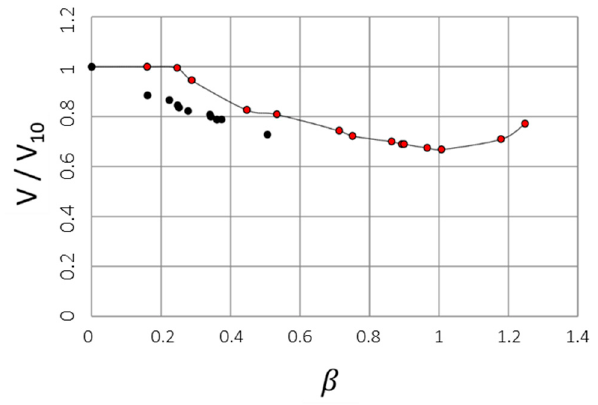
Figure 10. Volume ratio of PSS macrospheres as a function of binding ratio of lysozyme (black dots) and cytochrome c (red dots).